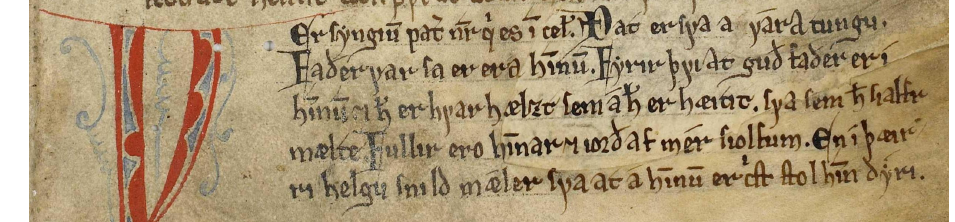
Figure 2: The Old Norwegian homily book. AM 619 4to, c 1200–25, the Arnamagnæan Institute, University of Copenhagen. Image by Suzanne Reitz. Fol. 76r, lines